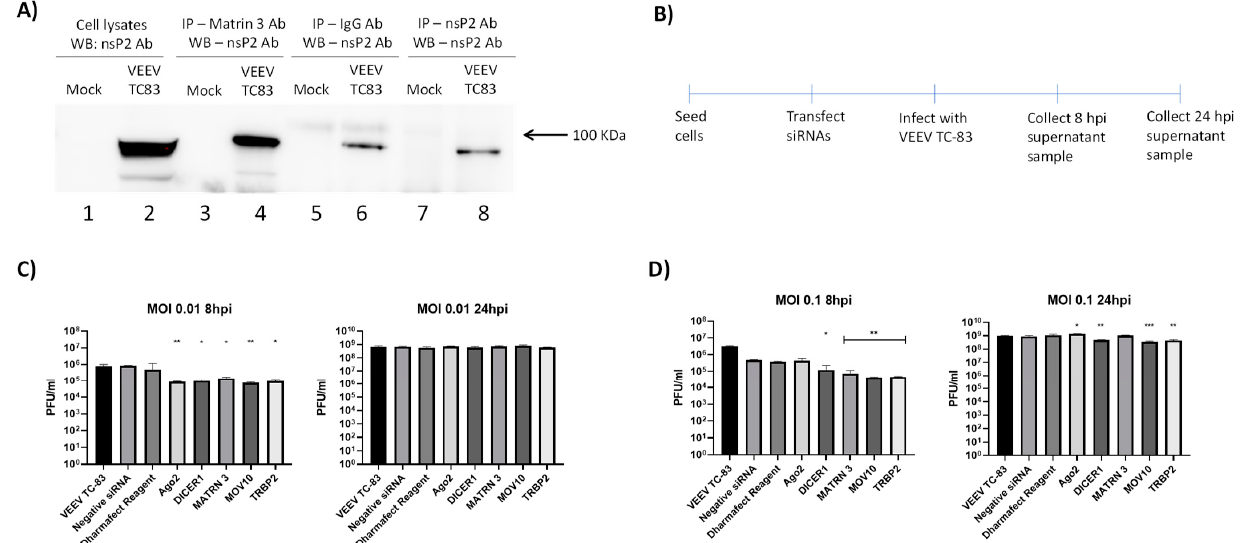
Figure 7. VEEV interaction with RNAi pathway. ( A ) 293T cells were infected with VEEV TC-83 at an MOI of 1.0 and lysates were collected at 18 hpi. Lysates were immunoprecipitated using anti-Martin 3, anti-nsP2 and IgG antibodies, and analyzed by Western blot to determine interaction with nsP2. ( B ) Schematic representation of steps involved to knockdown RNAi pathway protein. ( C , D ) 293T cells were transfected with siRNAs for Ago2, Dicer, MOV10, TRBP2 or Martin 3. ( C ) Cells were infected with TC-83 at an MOI of 0.01 and cell supernatants were collected at 8 and 24 hpi. ( D ) Cells were infected with VEEV TC-83 at an MOI of 0.1 and cell supernatants were collected at 8 and 24 hpi. Viral titer was determined via plaque assay and negative siRNA was used as a control. Results are representative of three independent experiments ( n = 3). * p < 0.0332, ** p < 0.0021, *** p < 0.0002.